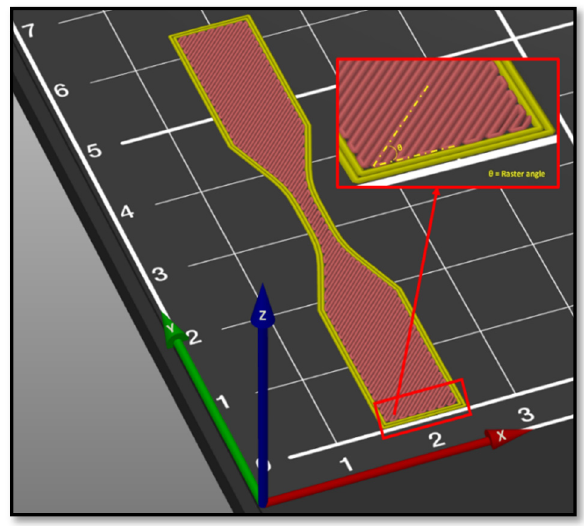
Figure 9. Schematic of raster angle in a 3D printed part.